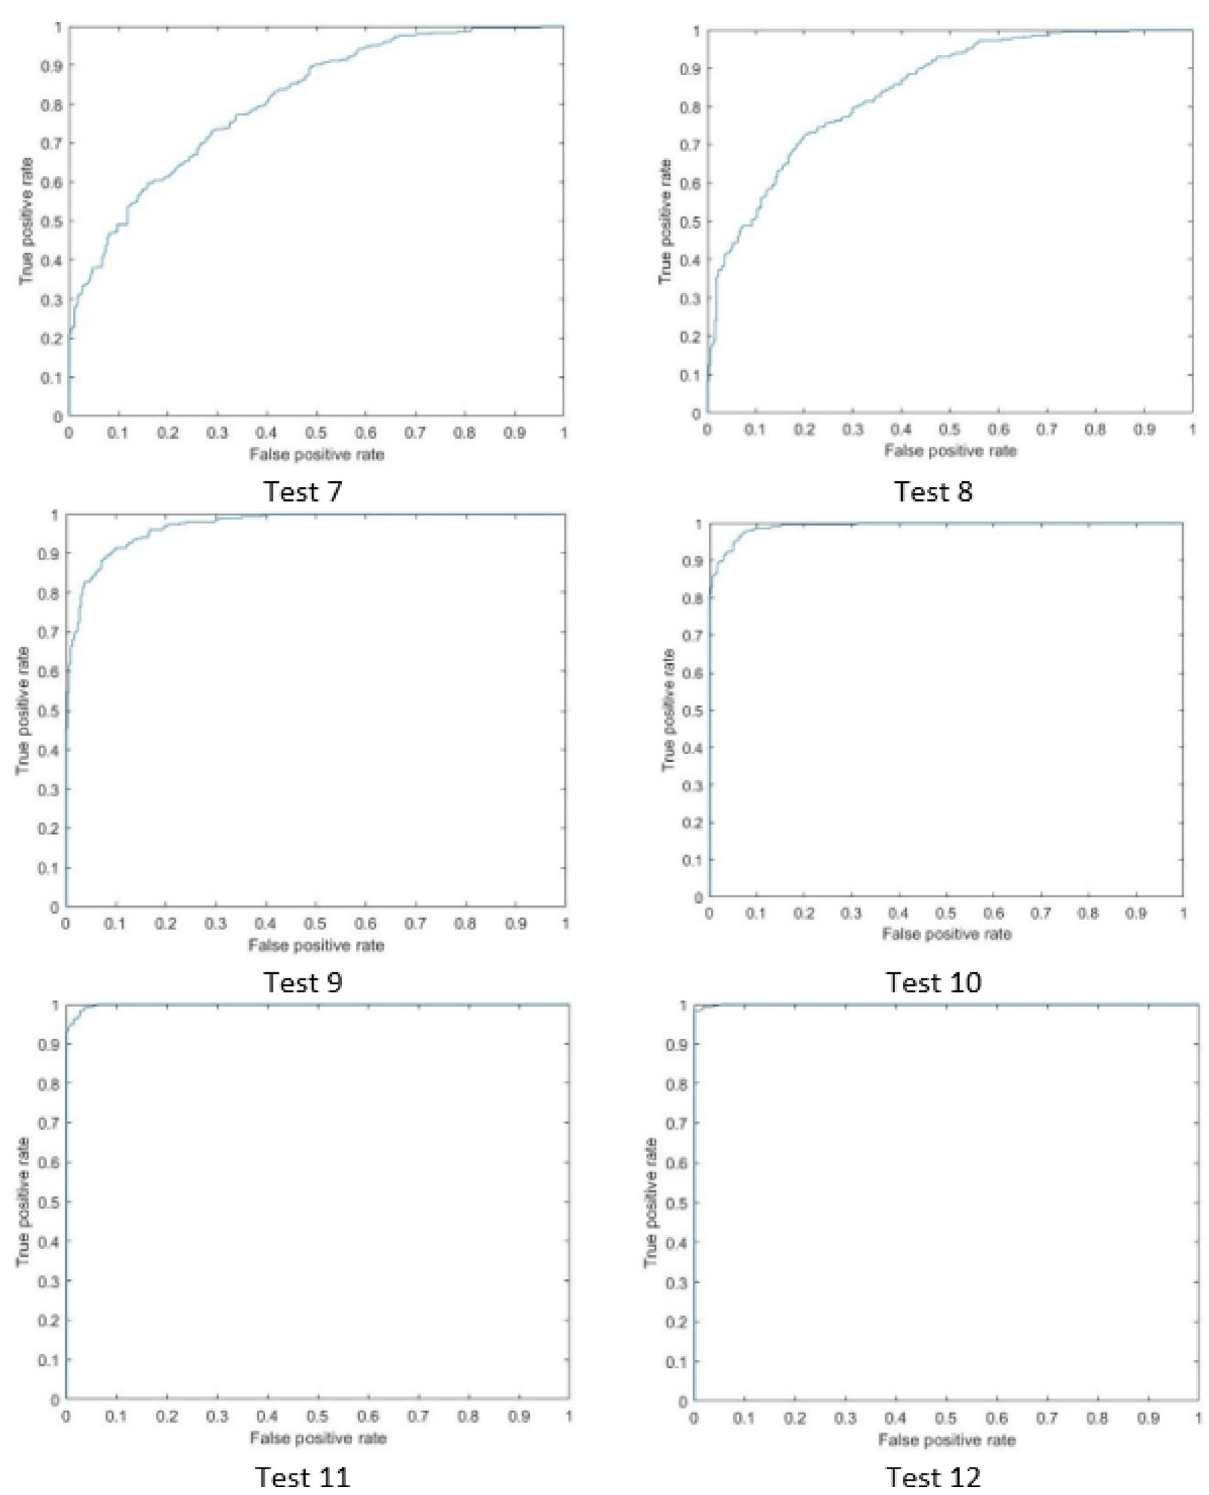
Figure 10. The ROC curve of the second six tests in our proposed